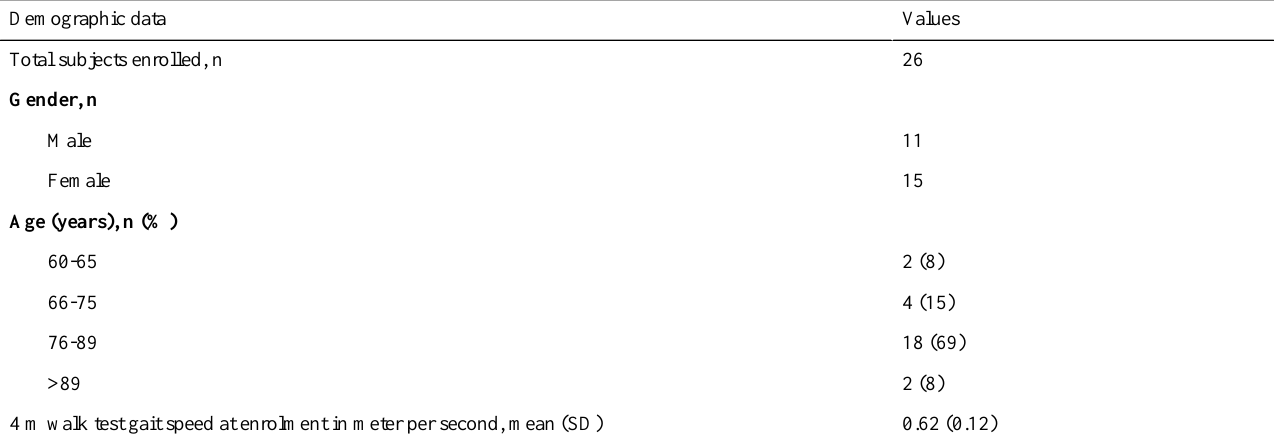
Table 1. Summaries of demographic data for subjects included in the independent validation study. ValuesDemographic data